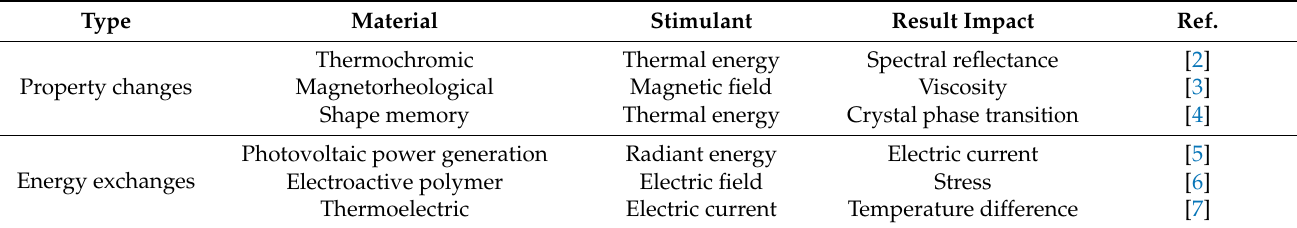
Table 1. Smart material classification.